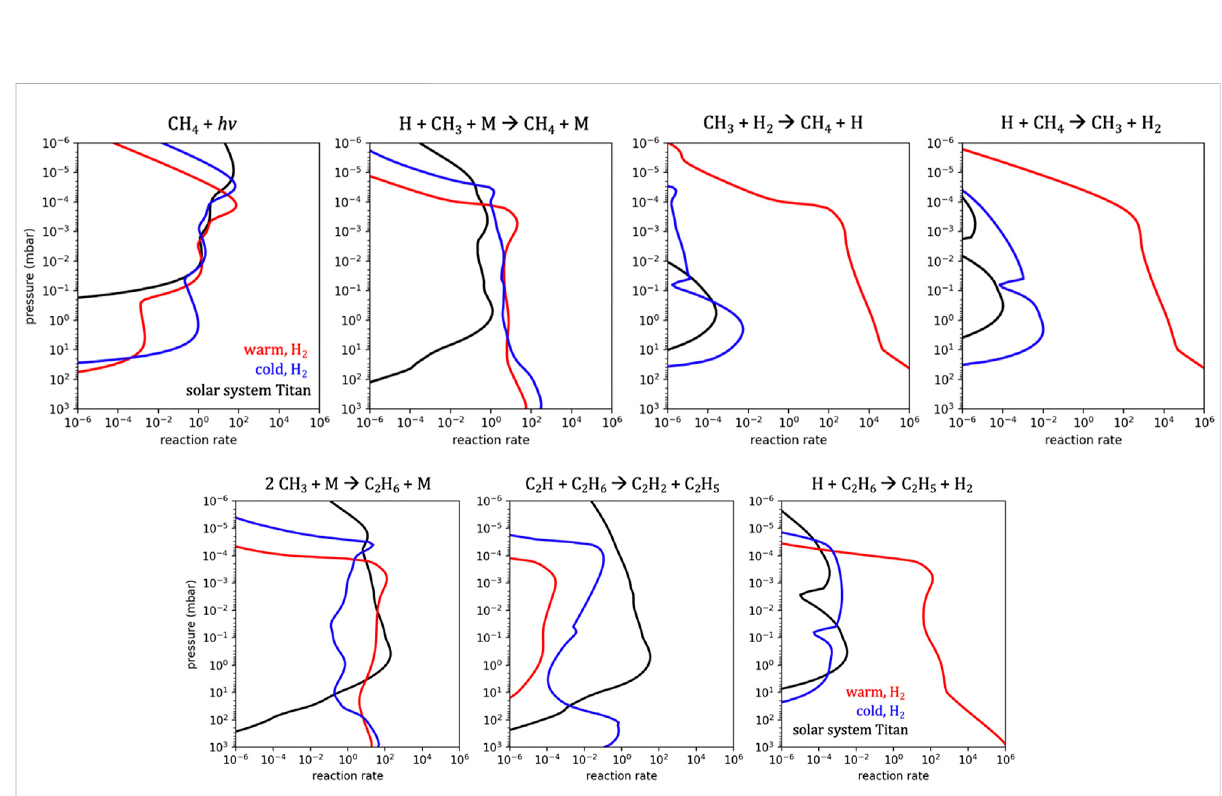
FIGURE 8 Reaction rates (cm − 3 · s − 1 ) of CH 4 -CH 3 recycling and dominant production and destruction reactions for C 2 H 6 . Black lines represent a cold N 2 atmosphere (Titan), blue lines represent a cold H 2 atmosphere, and red lines represent a warm H 2 atmosphere.